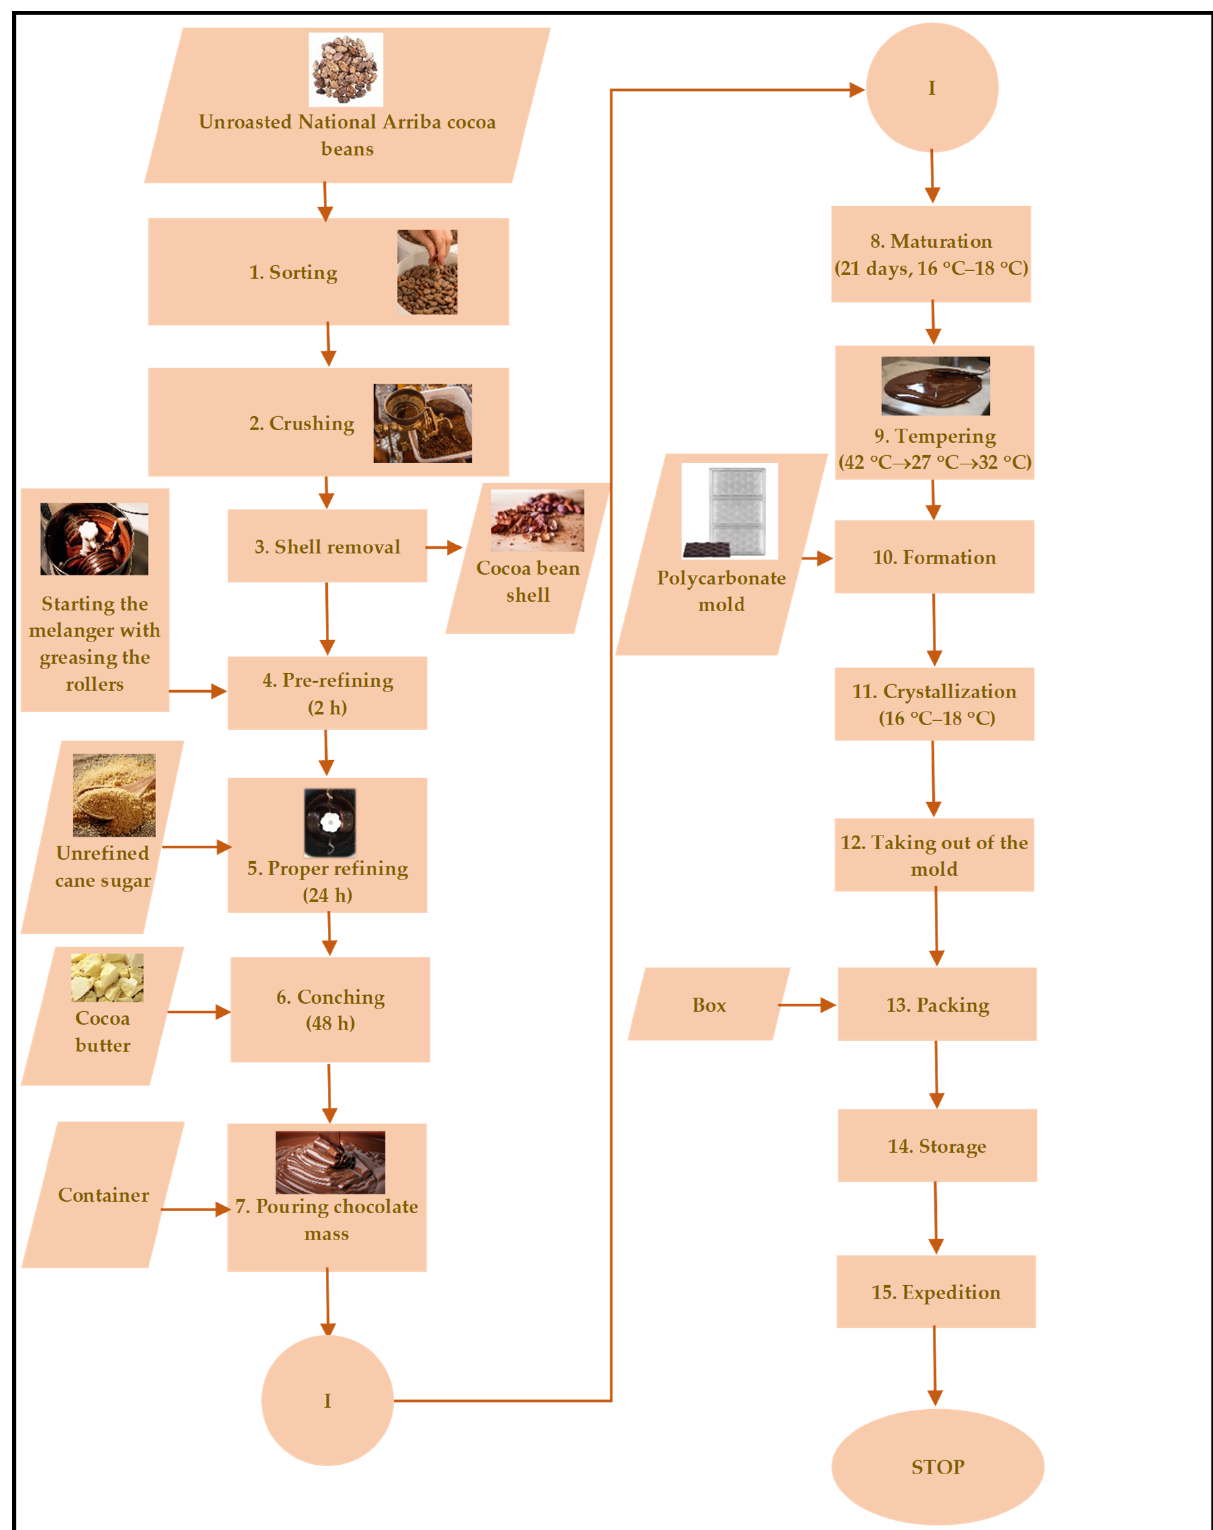
Figure 1. Block diagram of the process of raw chocolate